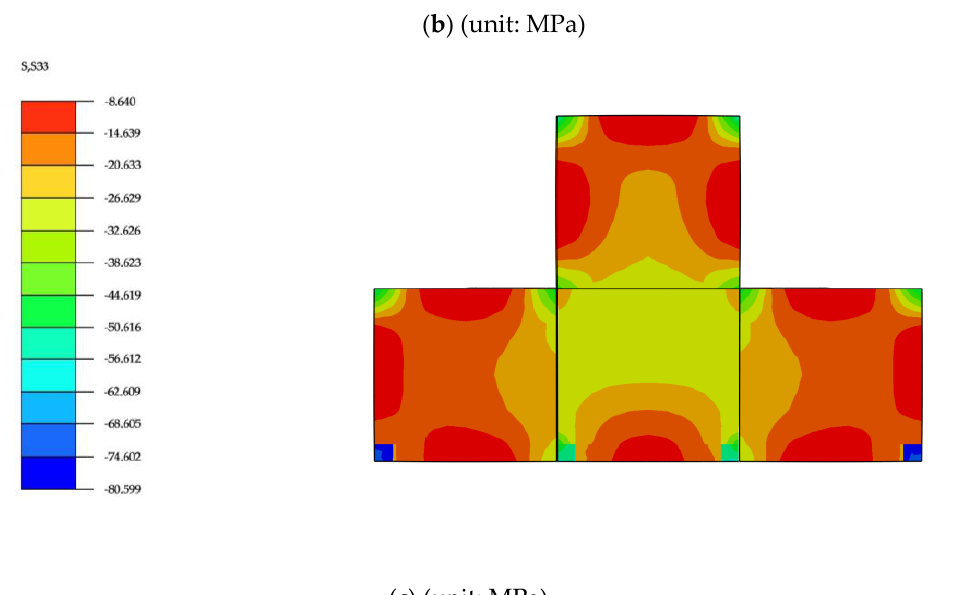
Figure 12. Stress cloud diagram when the load reaches ( a ) 50% N u ; ( b ) N u ; ( c ) 80% N u .